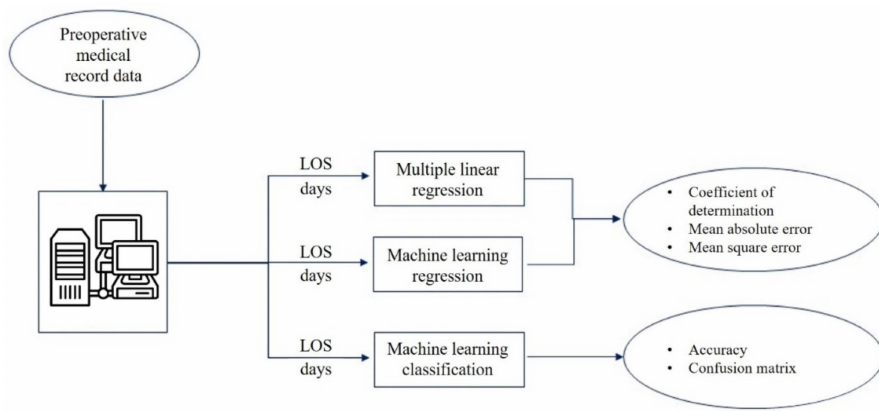
Figure 1. Workflow of the